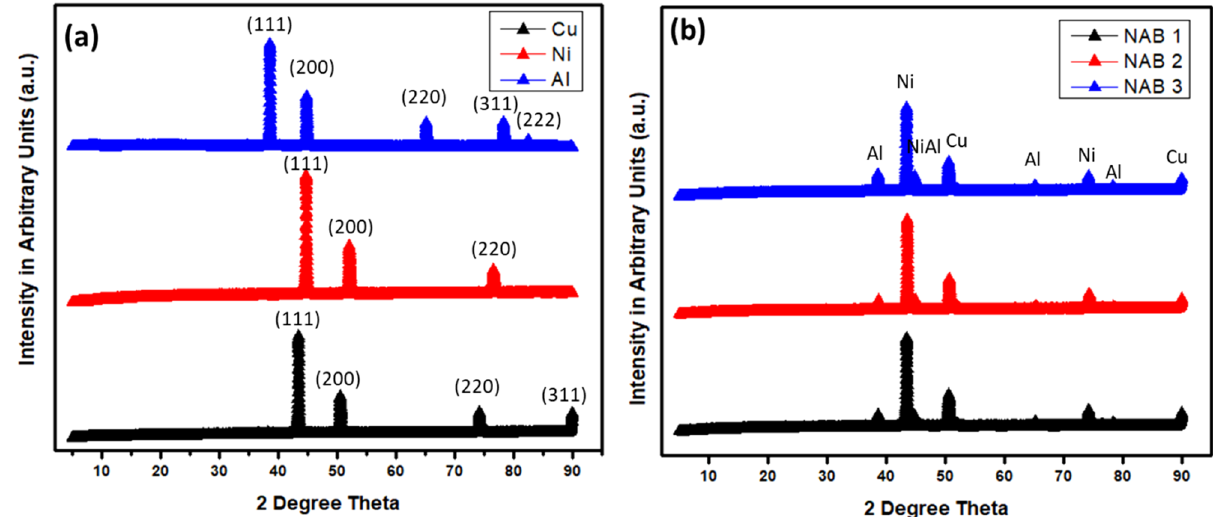
Fig. 4. XRD results of the (a) Starting powders and (b) Mixed powders.